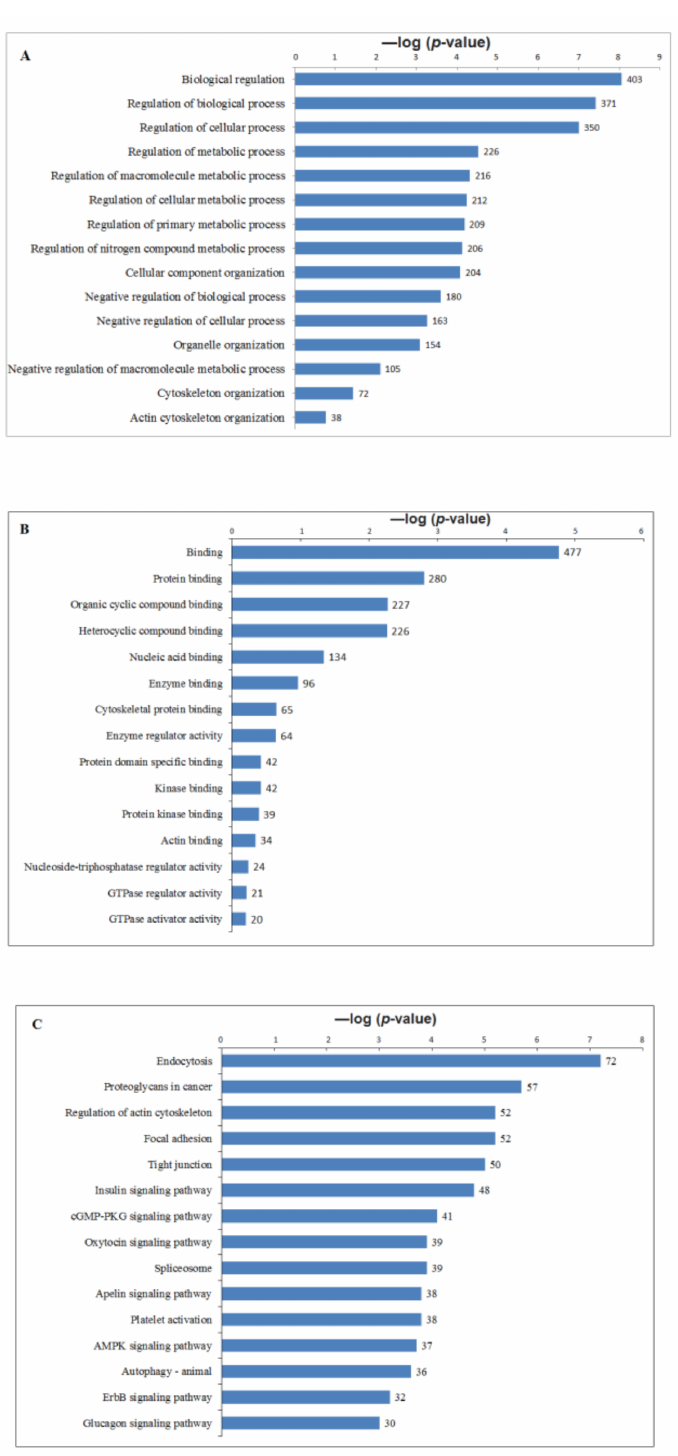
Figure 3. Significant altered phophopeptides were enriched by Gene ontology using BINGO in Cytoscape. Bar graphs summarizing the GO enrichment analysis, molecular function and pathways for the phopho peptides of CLA vs. CON subcutaneous and omental AT in dairy cows. The − log10 ( p - value) on the x -axis and GO terms represented on Y -axis. ( A ) Top 15 significant GO terms associated with the phospho peptides in CLA vs. CON. ( B ) Top 15 molecular functions of the phospho peptides in CLA vs. CON. ( C ) Top 15 KEGG pathways enrichment analysis for the phospho peptides in CLA vs. CON. Number of peptides in each category was labelled on the